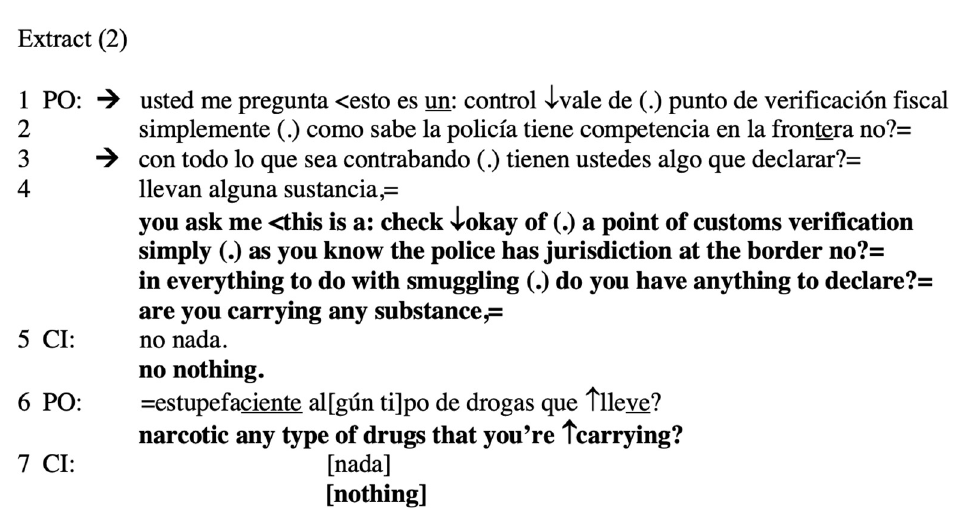
Figure 4. Extract